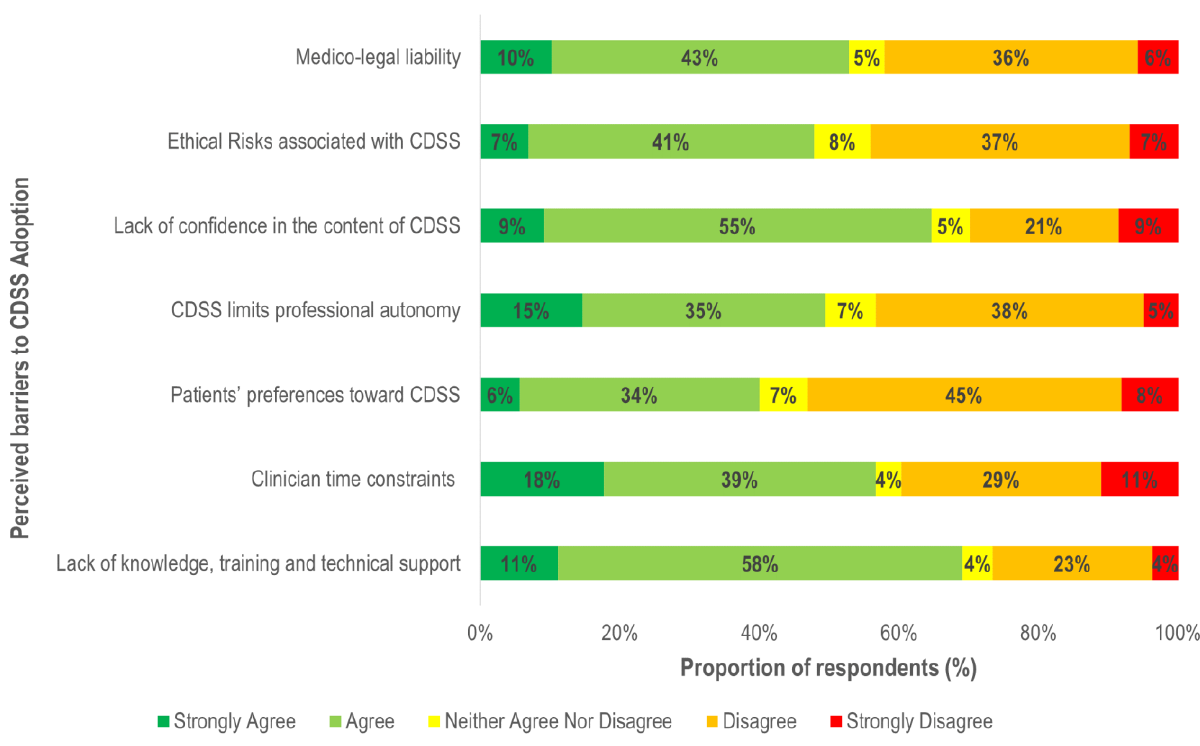
Figure 4. Reported barriers to CDSS adoption.